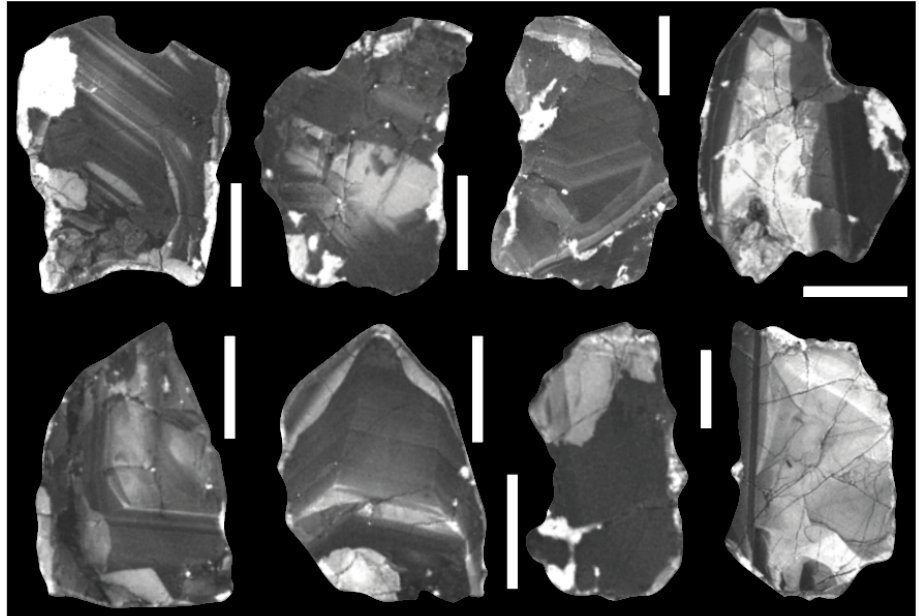
Figure 6. Cathodoluminescence images of selected zircon grains of the D3 sample. The scale (white rectangle) measures 50 μ m.